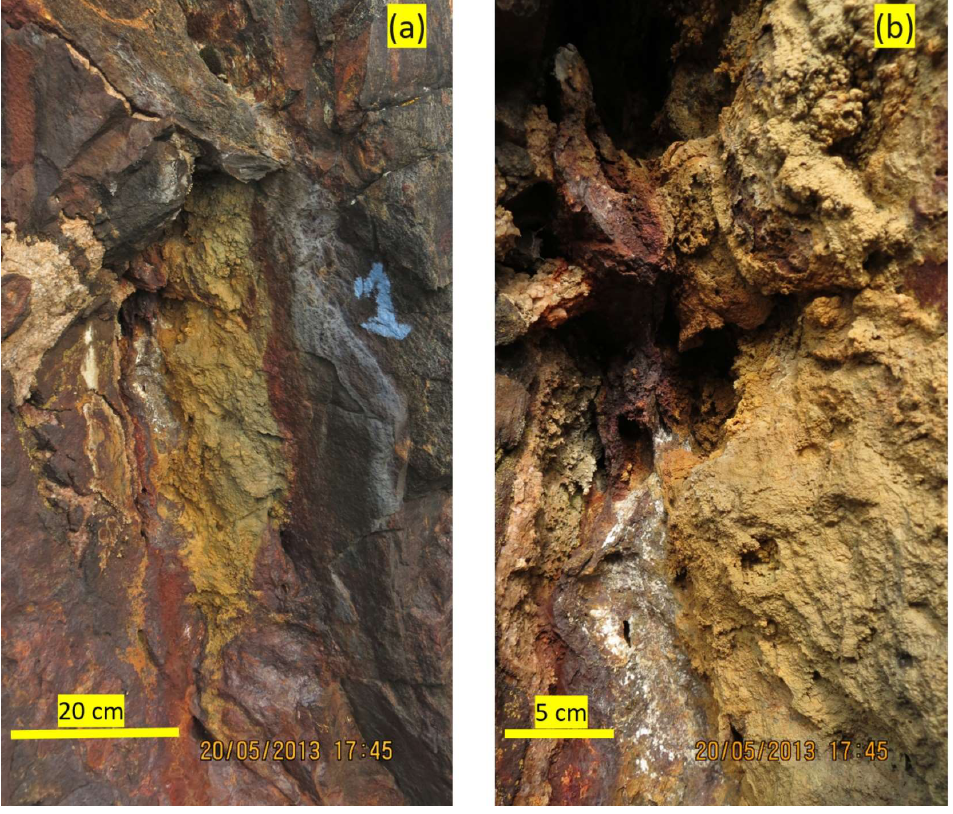
Figure 24. Jarosite formation at one spot of Stefføya. The image to the right ( b ) is the closer view